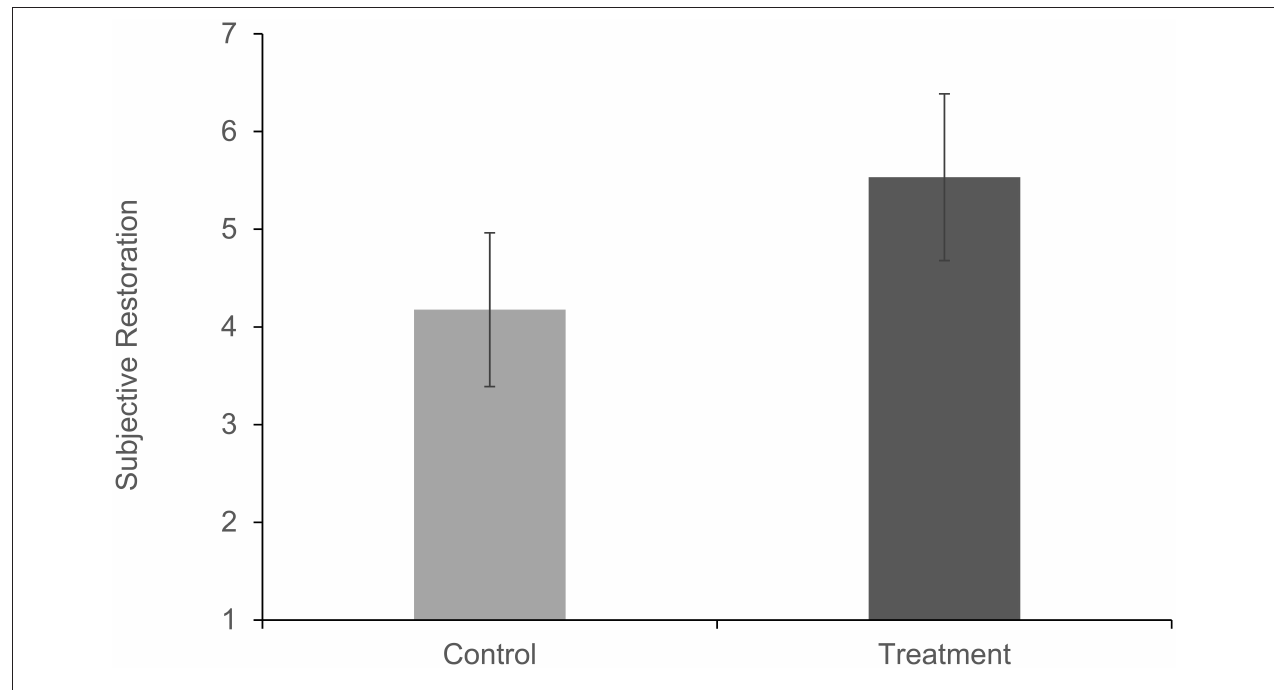
FIGURE 4 | Subjective restoration by condition. Error bars represent 95% CI.